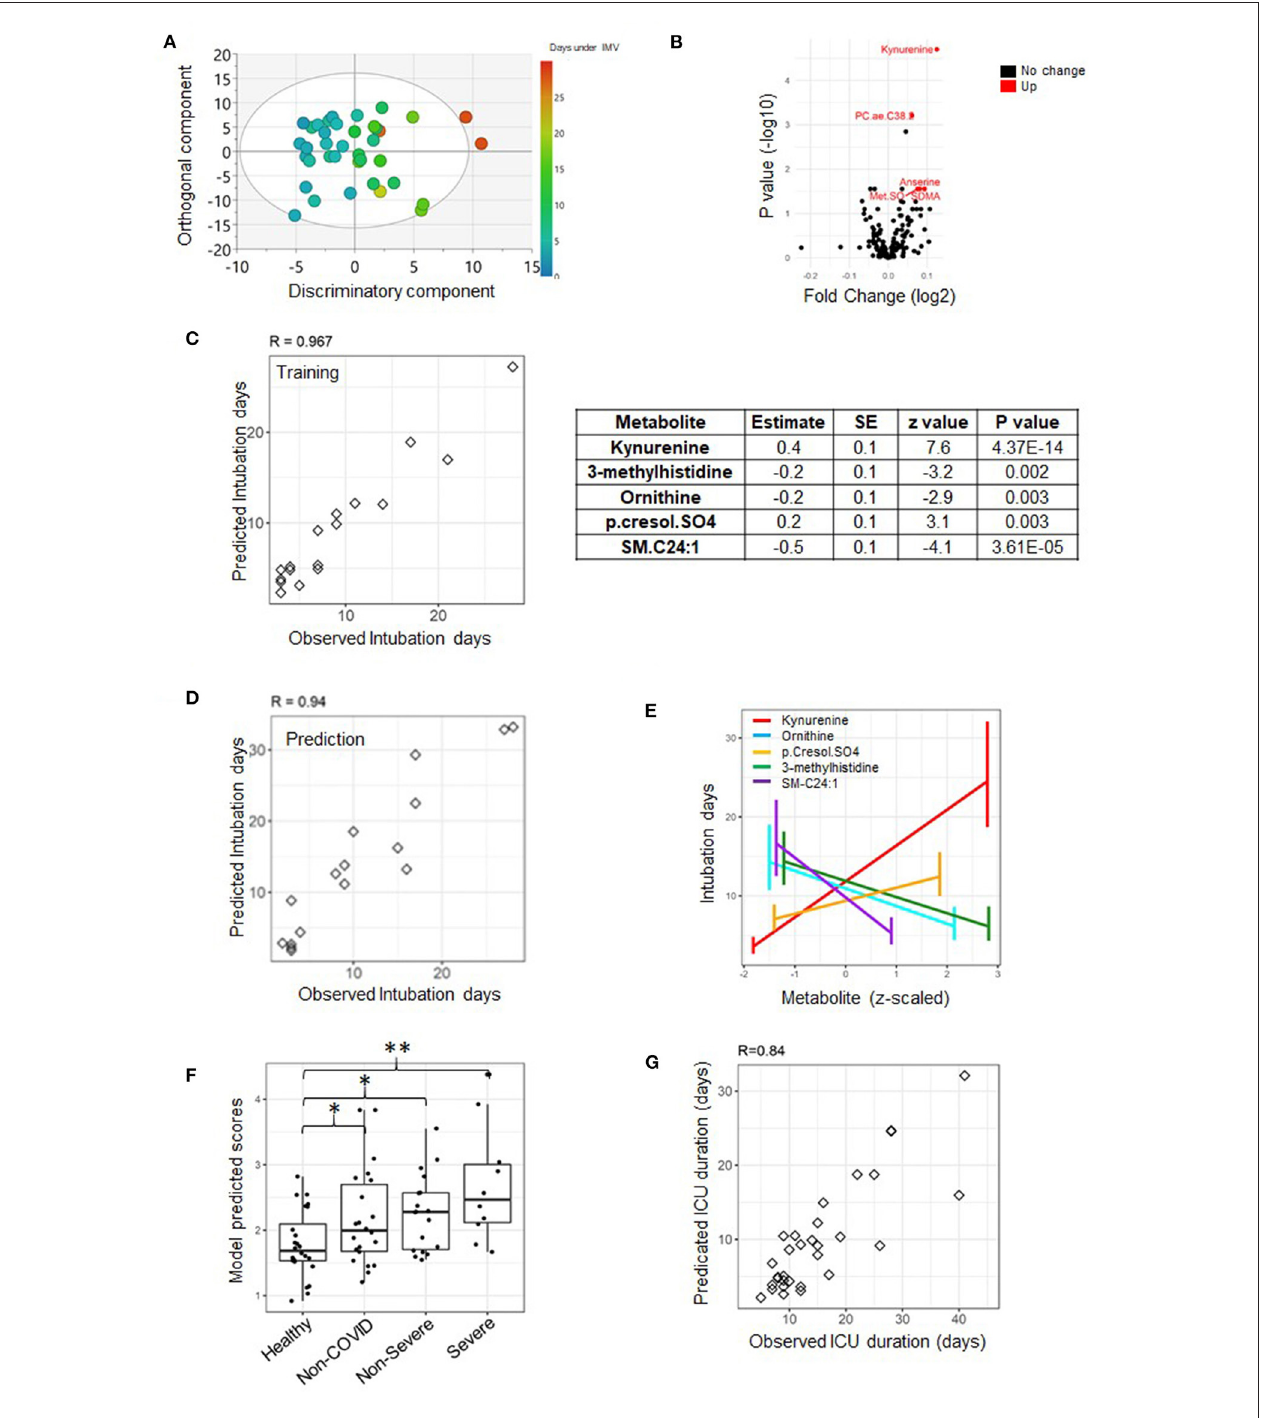
FIGURE 4 | A predictive model of duration of invasive mechanical ventilation (IMV) based on measurements from day seven. An OPLS score plot showing the class-discriminatory component ( x -axis) vs. orthogonal component ( y -axis) for duration of IMV, the discriminatory component explaining up to 94% of the variation in the Y phenotype variable (A) . A volcano plot showing top associated metabolites (log fold change > 0.06, adjusted p ≤ 0.05) with duration of IMV from the linear model based on the training set (B) . An analysis of the training set ( n = 17) revealed that the best predictive model only featured metabolites and none of the clinical traits (C) , and the model was validated on the prediction set ( n = 16) (D) . The model comprised of five predictive metabolites that either increased or decreased at day seven with longer intubation days (E) . When tested on published metabolomics data from non-ICU patients, it could reveal the extent of severity (* p < 0.05, ** p < 0.001) (E) . Data points were slightly scattered across the x -axis for ease of visualization in the boxplot in (F) . Using the model to predict the highly correlated number of days at ICU produced a correlation level of 0.84 with their observed counterparts (G) , superior to that based on day one.